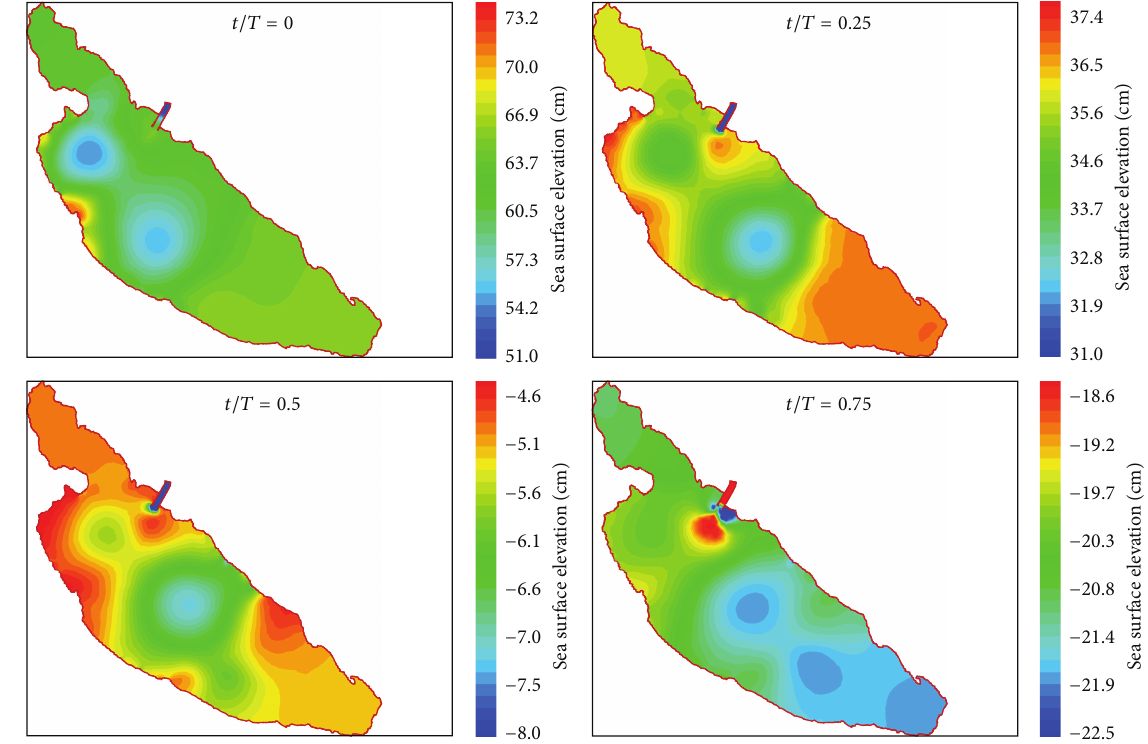
Figure 4: Time sea surface level in Nador lagoon during a typical period.